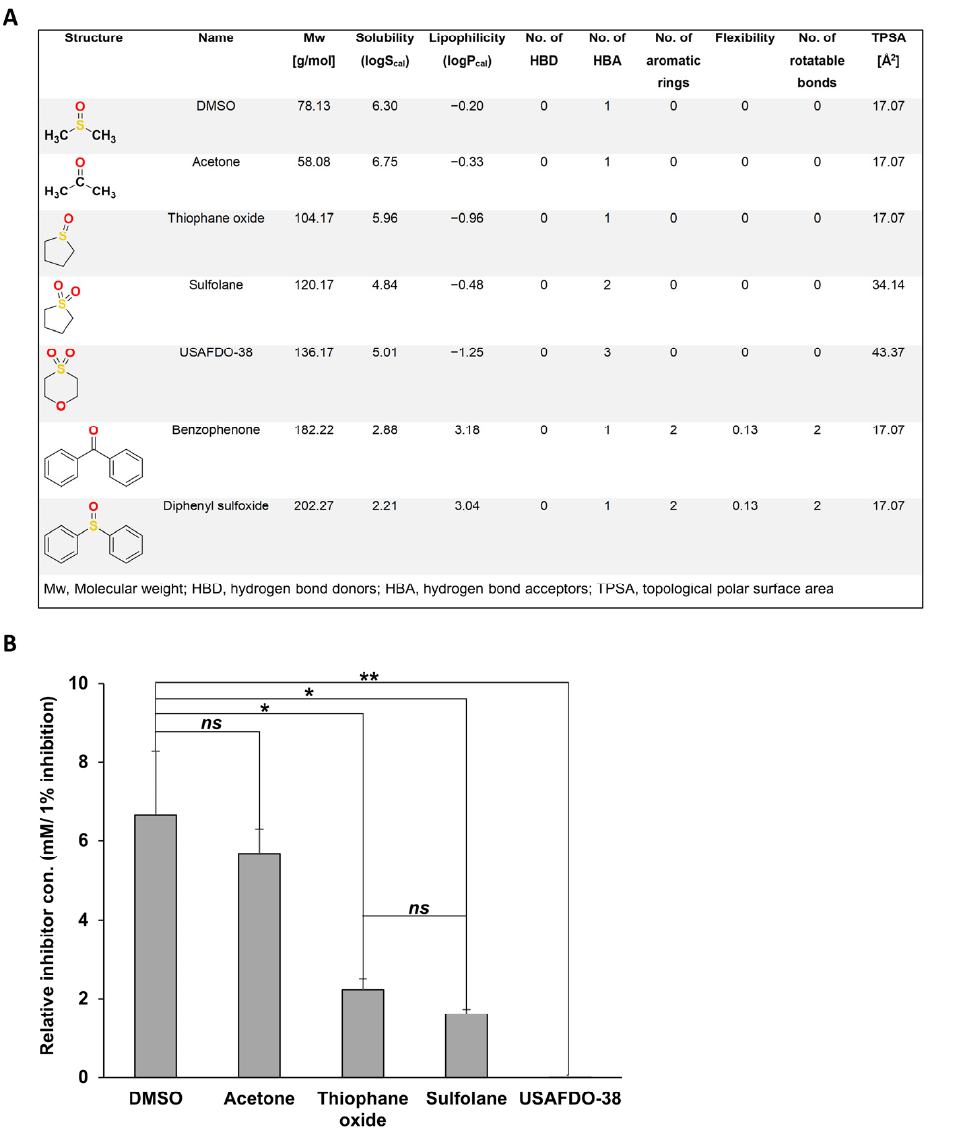
Figure 5. The effect of different DMSO derivatives on adenine self-assembly inhibition. ( A ) Physi- cochemical properties of different DMSO derivatives calculated by StarDrop (Optibrium). Oxygen atoms are shown in red; sulfur atoms are shown in yellow. ( B ) Kinetic analysis of adenine aggregation as measured in a ThT binding assay. Adenine was dissolved at 6 mg/mL in PBS and heated to 90 ◦ C to obtain a monomeric solution, followed by the addition of DMSO or its derivatives at the indicated concentrations (see Supplementary Figure S3). The controls for each compound were prepared as described in the Materials and Methods. ThT was added to a final concentration of 40 µ M, and fluorescence was measured over time with excitation and emission wavelengths of 450 nm and 480 nm, respectively. The relative concentration was calculated at an endpoint of 1000 min, and the concentration of the inhibitor was divided by the percentage of inhibition. The relative concentra- tion represents the minimal concentration required to inhibit 1% of adenine fibrilization (relative con. (mM/1% inhibition)) (see material and method section and supplementary Figure S3). ns, not significant; * p < 0.02; ** p < 0.01 (Student’s t -test). Values are the average ± s.d. of three independent biological